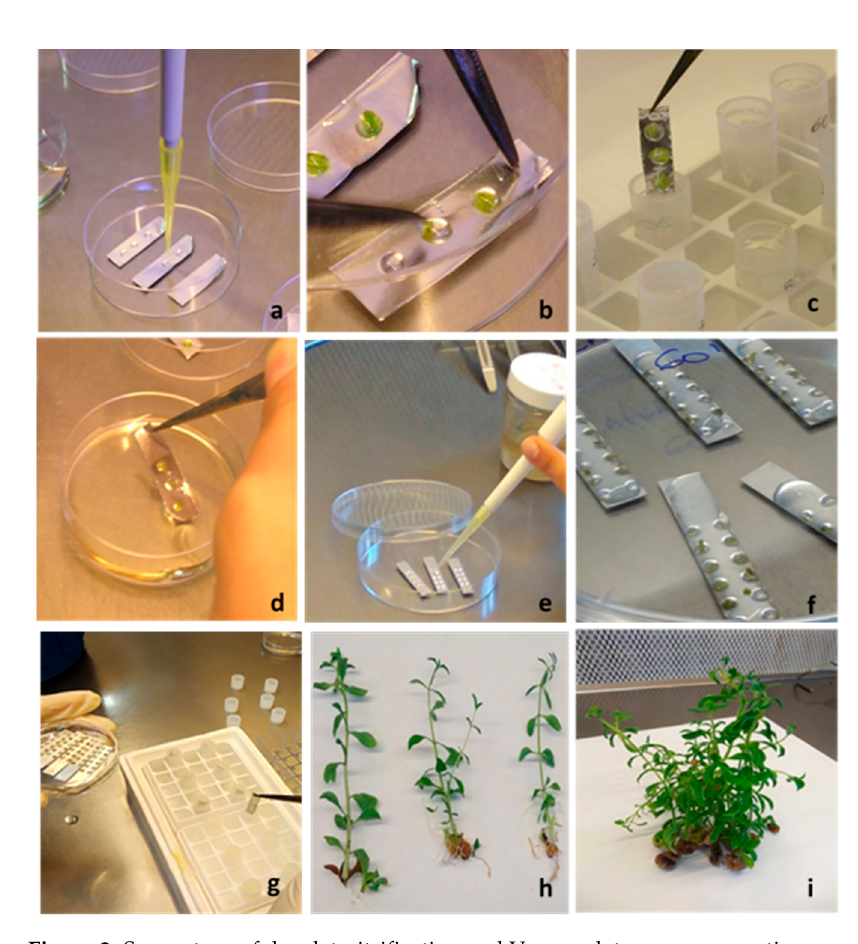
Table 2. First subculture after droplet-vitrification procedure: morphological parameters of S. rebaudiana shoots, from control and from cryopreserved apical shoot tips and axillary shoot tips. (Means ± SD).